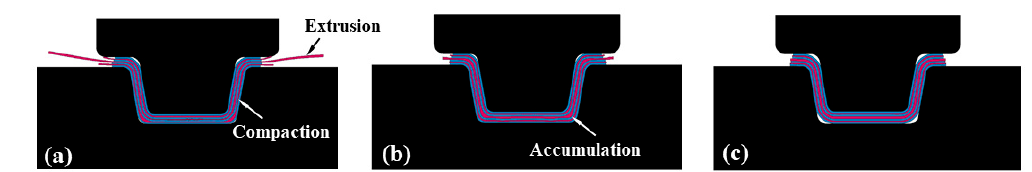
Figure 6. Influence of the Coulomb coefficient factor on inter-ply slippage. ( a ) µ = 0.01, ( b ) µ = 0.1, and ( c ) µ = 0.2. The predicted cross-section of the hat profile channel for lay-up L2 is compared with experimental data in Figure 7. To obtain the appropriate friction coefficient, values of 0.05, 0.1, and 0.2 were applied between the aluminium and polymer plies. The predicted cross-section of the hat profile was compared with the experimental data at a forming load of 10.0 kN, at which point the profile was not fully formed. Figure 7a–c shows that applied. Comparison of the predicted and measured α indicates that the cross-section of the produced hat profile channel was very similar to the cross-section predicted using the coefficient factor of 0.1. The friction coefficient between the dies and workpiece was fixed at 0.1 in all simulations. Thus, the inter-ply friction coefficient, and the friction coefficient between the dies and workpiece, were set at 0.1 in subsequent simulations.